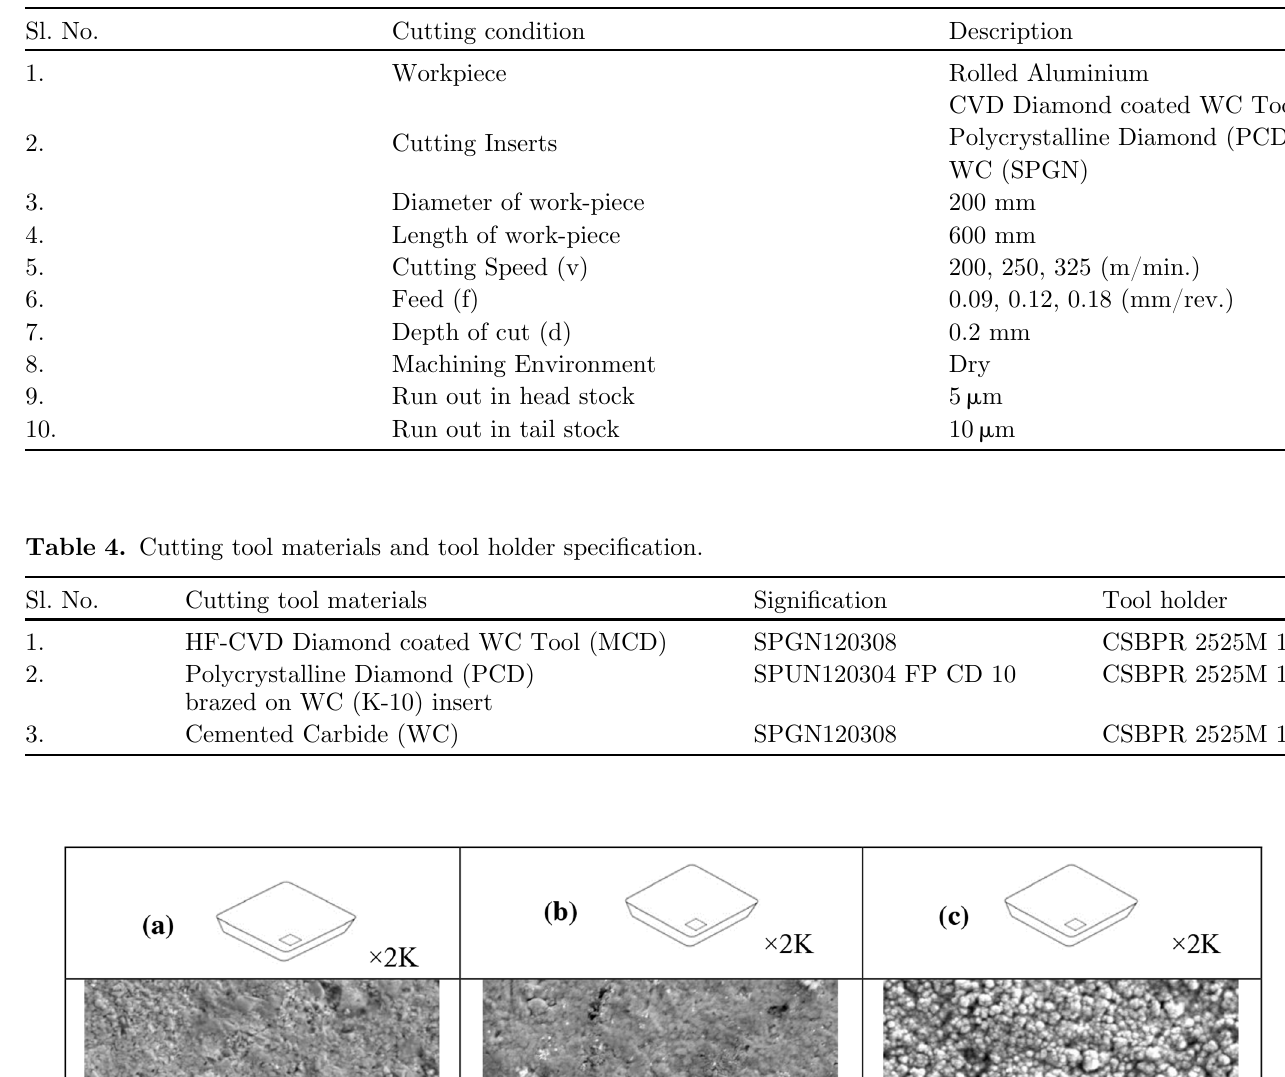
Table 3. Description of cutting condition.